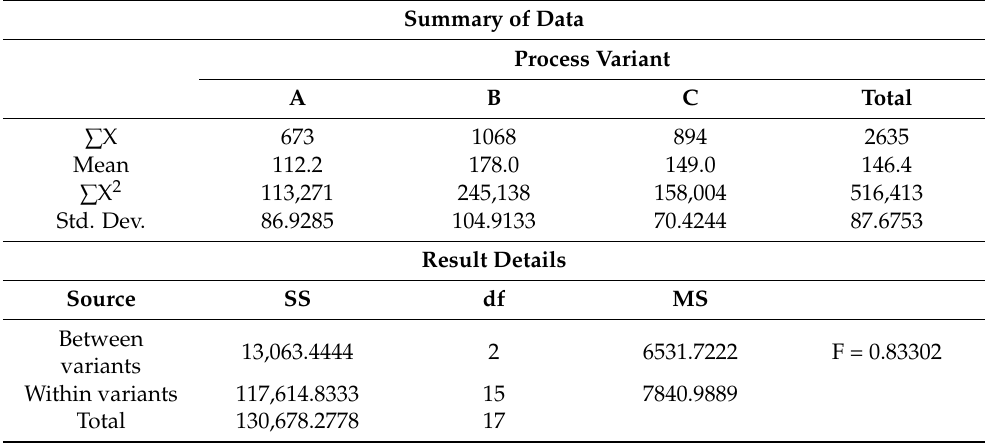
Table 13. Effect of ANOVA of process selection size on log sawing efficiency index ( p < 0.05).